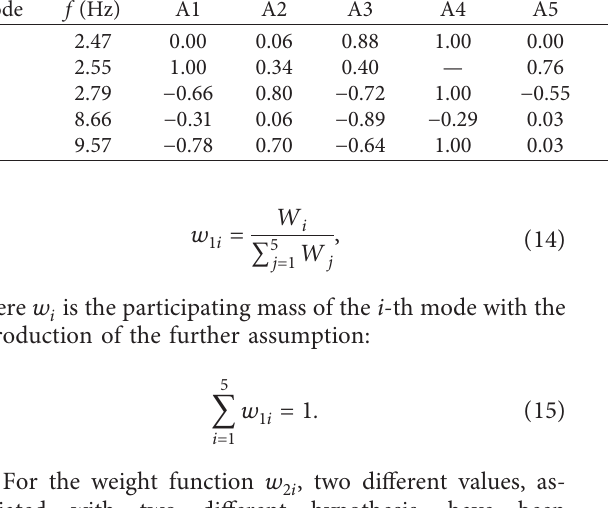
Table 5: Frequencies and mode shape components experimentally identified and used for the comparison with the FE model results.